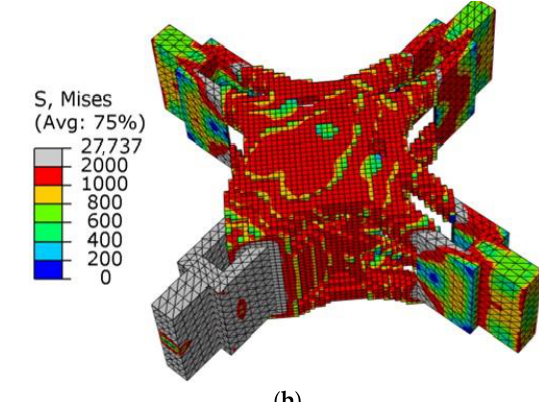
10 of 18 Figure 9. Optimization process under the condition of axial force (the black dotted line is the change curve of compliance C, and the red dotted line is the volume-reduction curve). 3.3.2. Shear Conditions Similarly, when the target volume fraction was set to 20%, the evolution rate was 0.08, the optimization target was the maximum stiffness, and the shear condition analysis